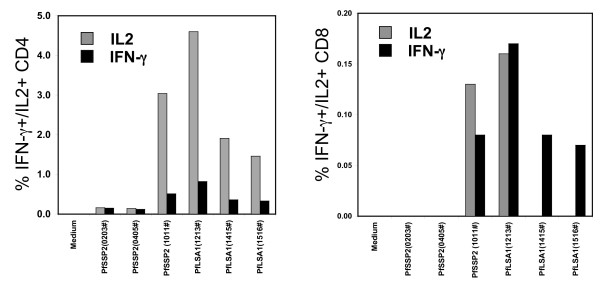
Intracellular IFN-γ and IL-2 expression by CD4+ or CD8+ T cells. PBMC from monkey R immunized with CSLAM/PBS, collected at preimmunization and 4 weeks post virus boost time points, were assayed against PfSSP2/TRAP, or PfLSA1 peptide pools by intracellular cytokine staining. Data represent the percentage of CD4+ or CD8+ IFN-γ and IL-2 producing T cells. Note differences in the y-axis scales between CD4+ and CD8+ responses.